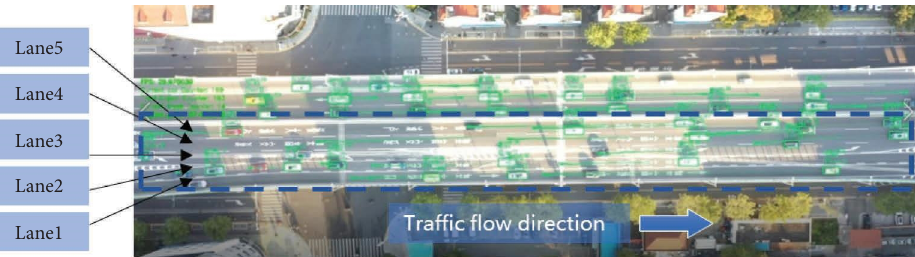
Figure 3: YOLO deep learning for vehicle information extraction.